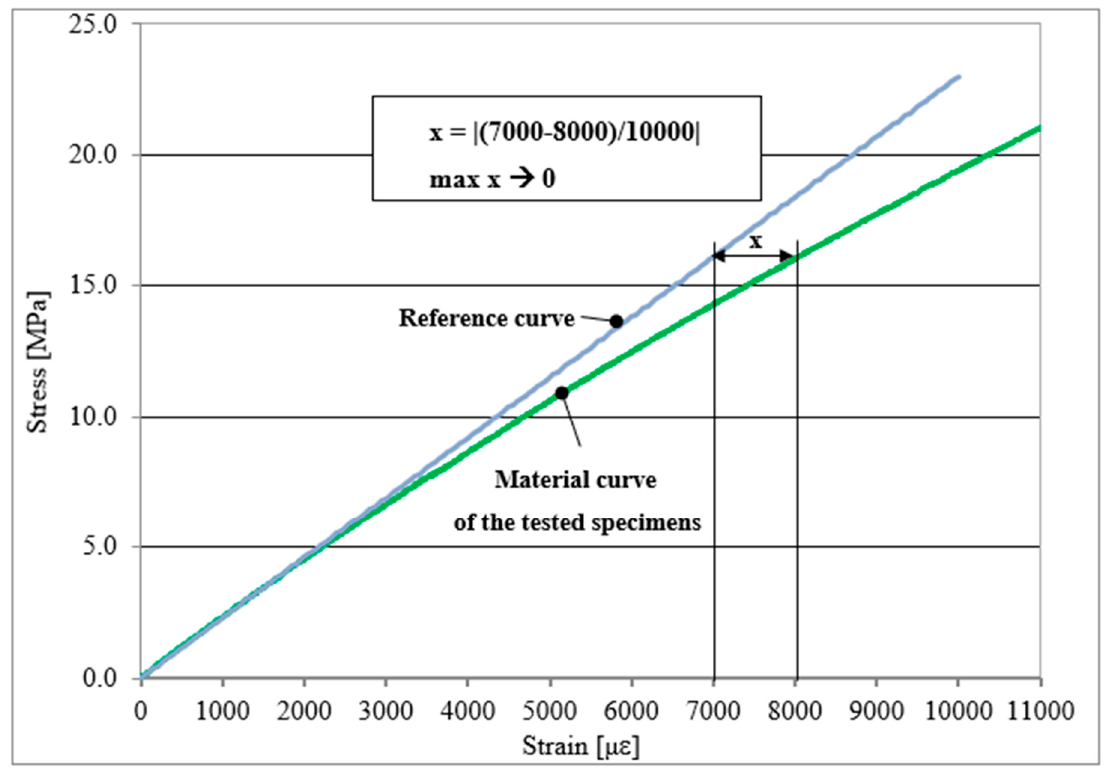
Figure 3. Scheme of linearity estimation; blue line—reference curve for specimens printed vertically or horizontally, green line—stress-strain material curve of the tested specimens.